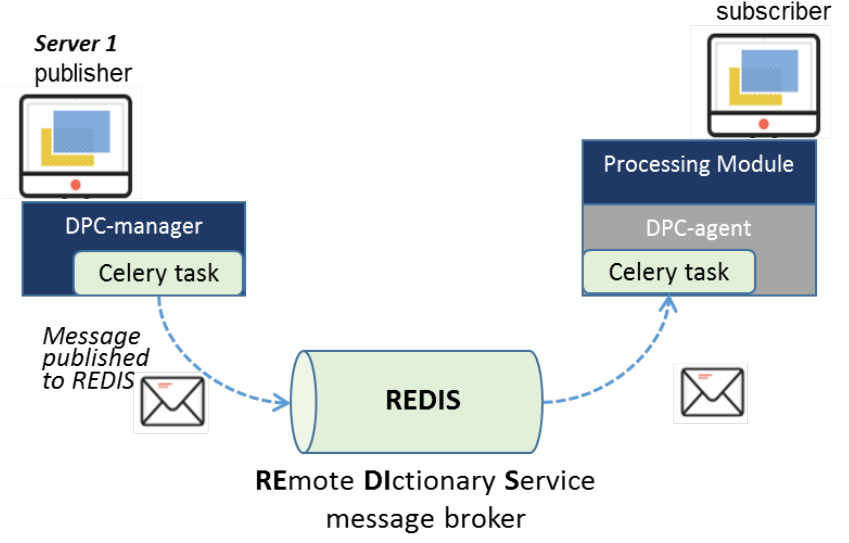
Figure 5. Schema of the communication between manager and agent. The communication is executed by means of messages managed by Celery (a task-processing